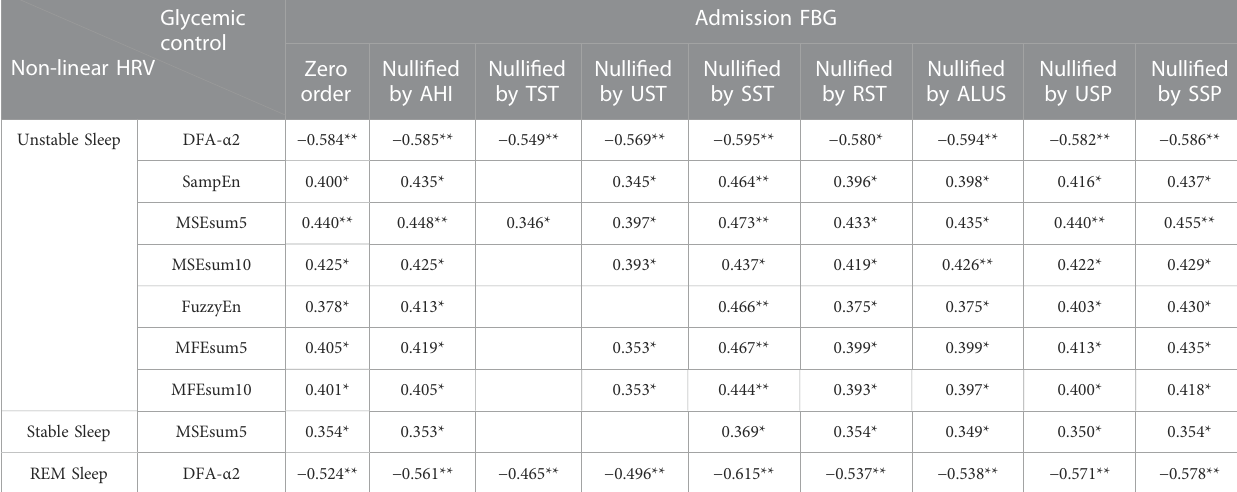
Table 10 demonstrates partial correlations between admission FBG and non-linear HRV metrics in 3 sleep stages. When nullifying the effect of SST, the correlations between HbA1c and non-linear HRV metrics at sleep stages signi fi cantly strengthened (e.g., SampEn